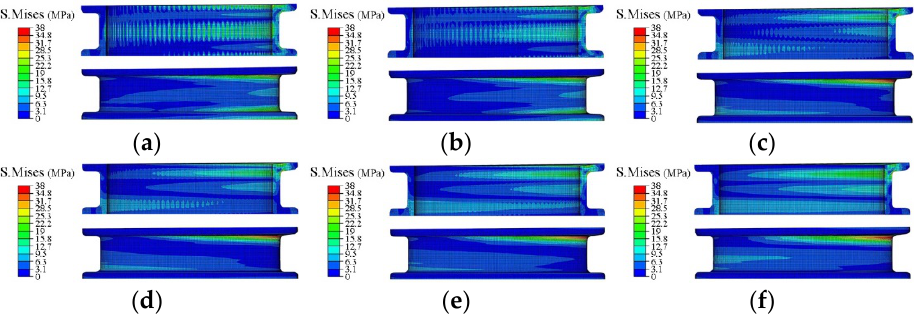
Figure 10. Stress and contact pressure distributions of Cap-seal under initial conditions. ( a , c ) δ = 0 mm; ( b , d ) δ = 0.1 mm.